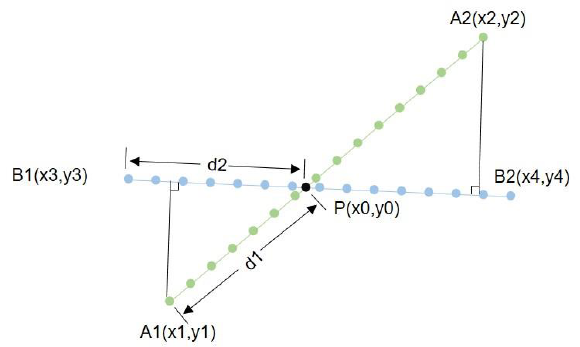
Figure 2. Diagram of crossover calculation for two assumed